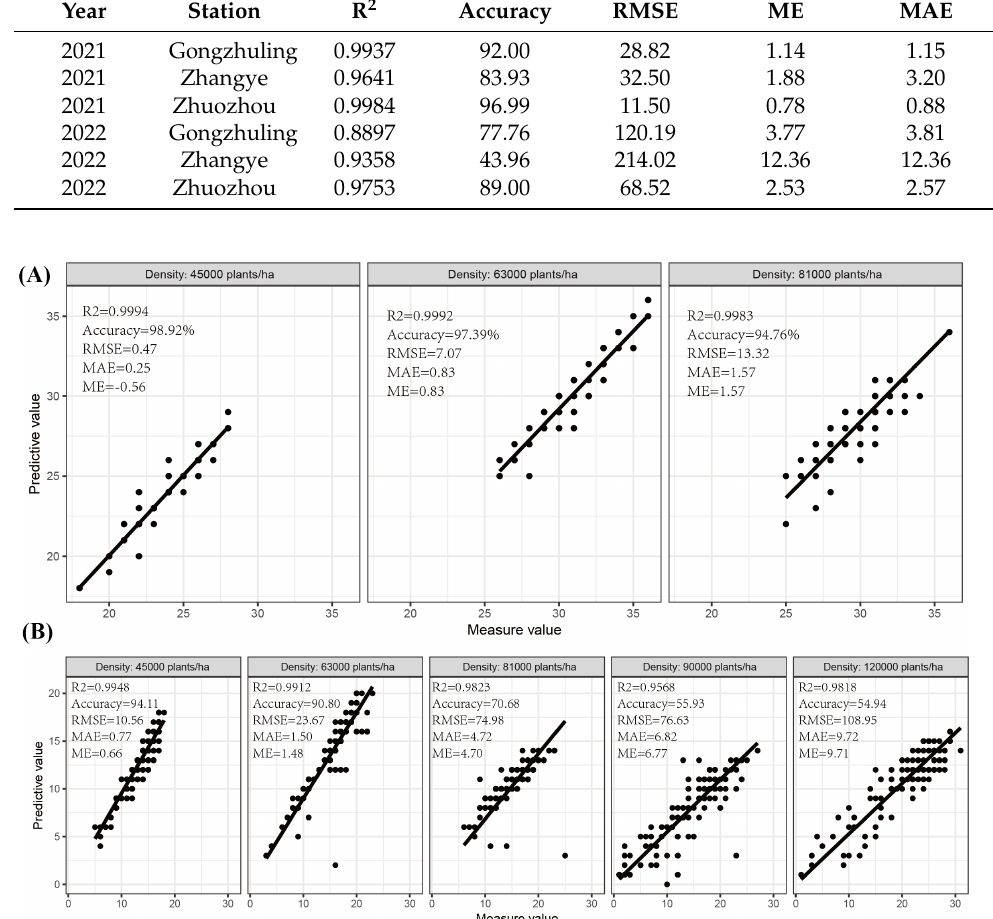
Figure 4. Evaluation of the seedling measurement system for predicting the seedling count of maize under different planting densities. ( A ) Prediction performance of the seedling measurement system in different planting density treatments at Zhuozhou Station in 2021; ( B ) prediction performance of the seedling measurement system in different planting density treatments at Gongzhuling Station in